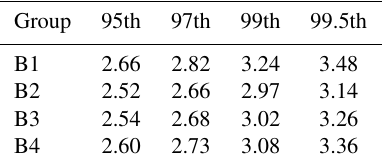
Table 2. F median value for the satellite configurations and for the four groups of sites (values are in terms of percentage, %).